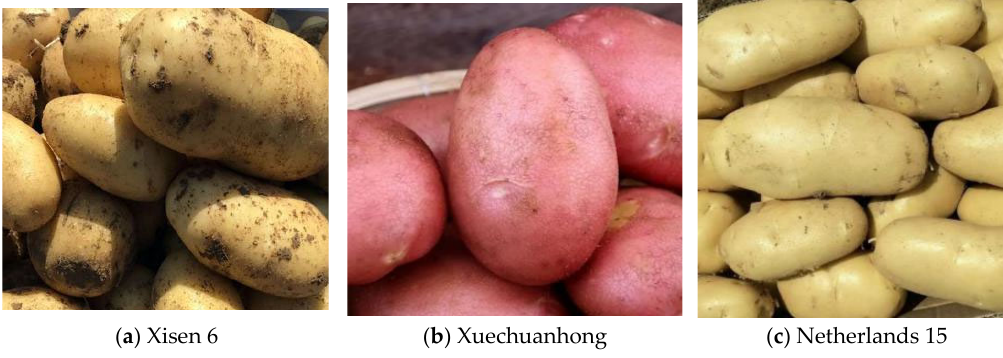
Figure 7. Relationship between potato varieties and evaluation indexes. Note: The standard devia ‐ tion range for the proportion of epidermal damage is 0–1, and the standard deviation range for the energy loss ratio is 1–6.